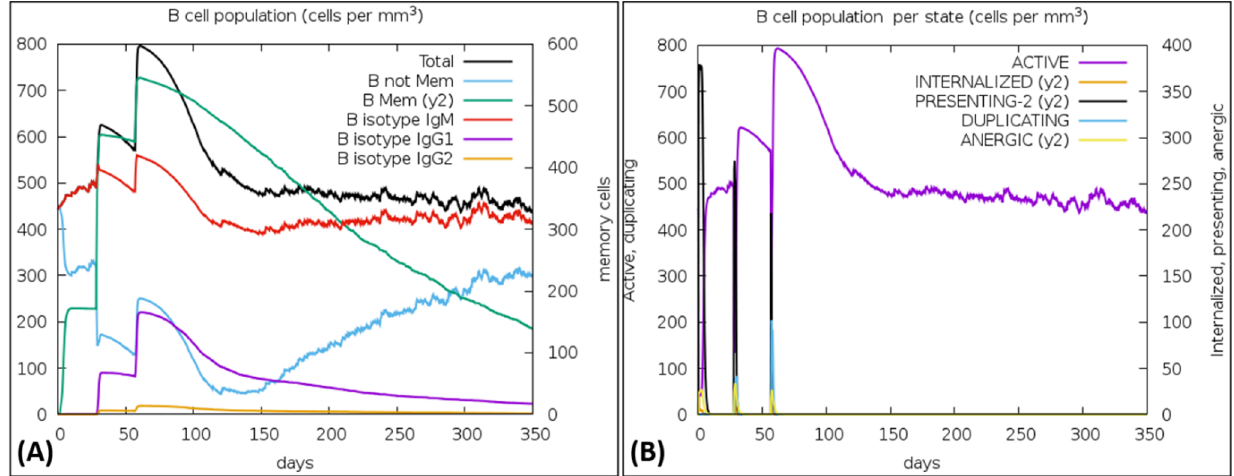
Figure 7. In silico replication of the pET28a (+) plasmid using SnapGene software to construct a recombinant